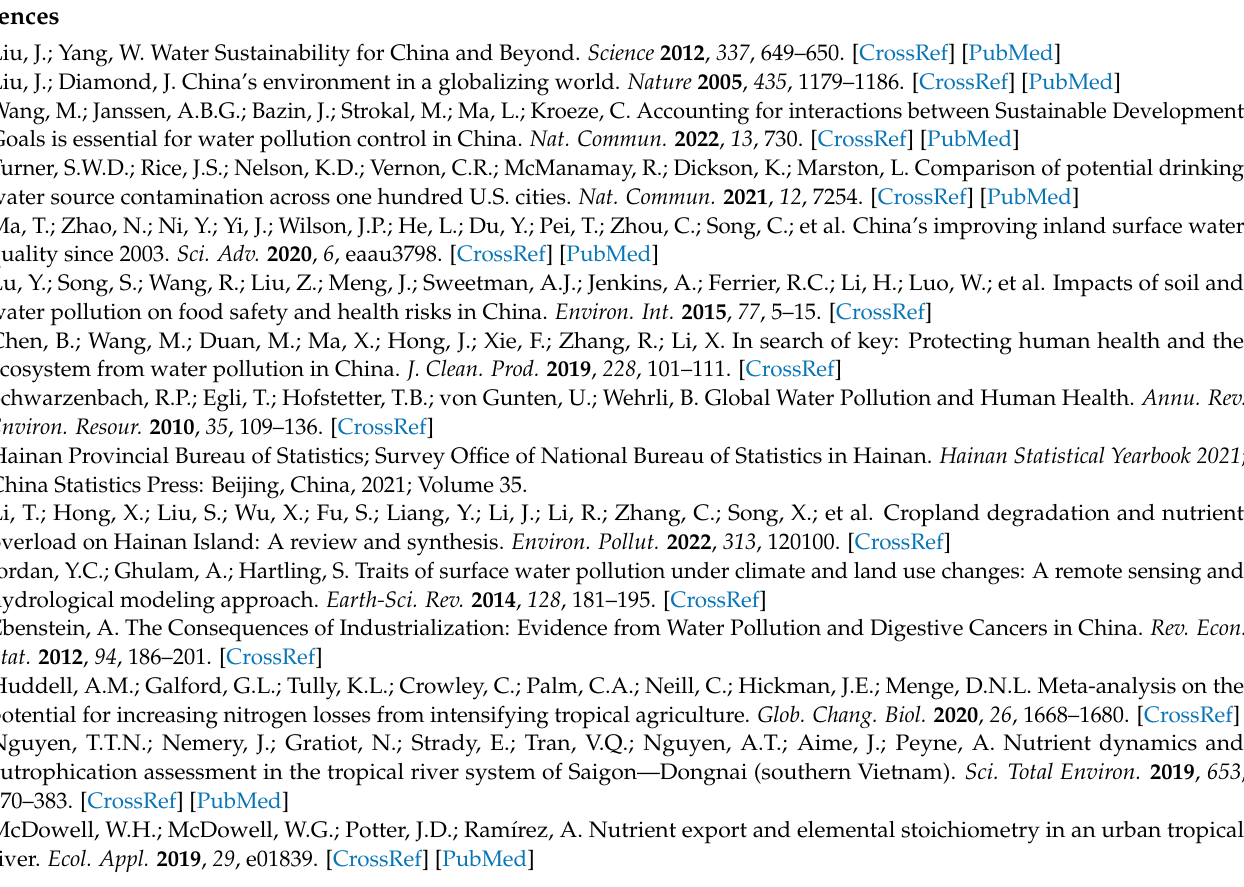
Table S3: statistical information of AN for all regions and seasons; Table S4: statistical information of TP for all regions and seasons; Table S5: statistical information of RFR for TN compare with previous regression equations in the testing dataset; Table S6: statistical information of ANN for TP compare with previous regression equations in the testing dataset; Figure S1: the spatial distribution of TN in NRD; Figure S2: the spatial distribution of AN in NRD; Figure S3: the spatial distribution of TP in